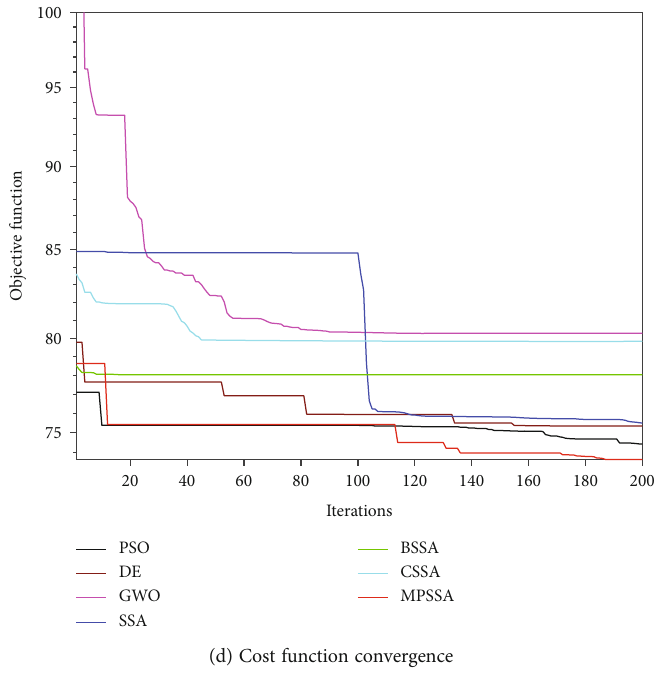
Figure 9: Single UAV track